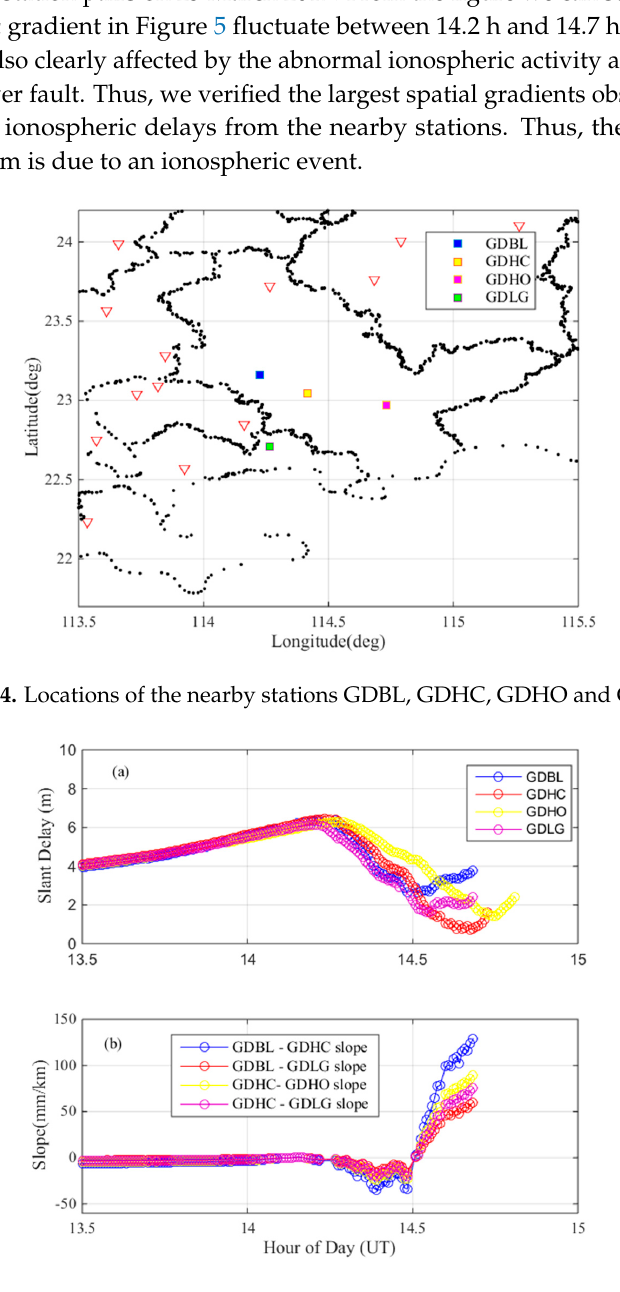
Figure 5. Ionospheric delay and gradient observed from the pairs of nearby stations on 25 March 2017. ( a ) dual-frequency estimates of slant ionospheric delay of nearby stations; ( b ) ionospheric gradient observed form the pairs of nearby stations.